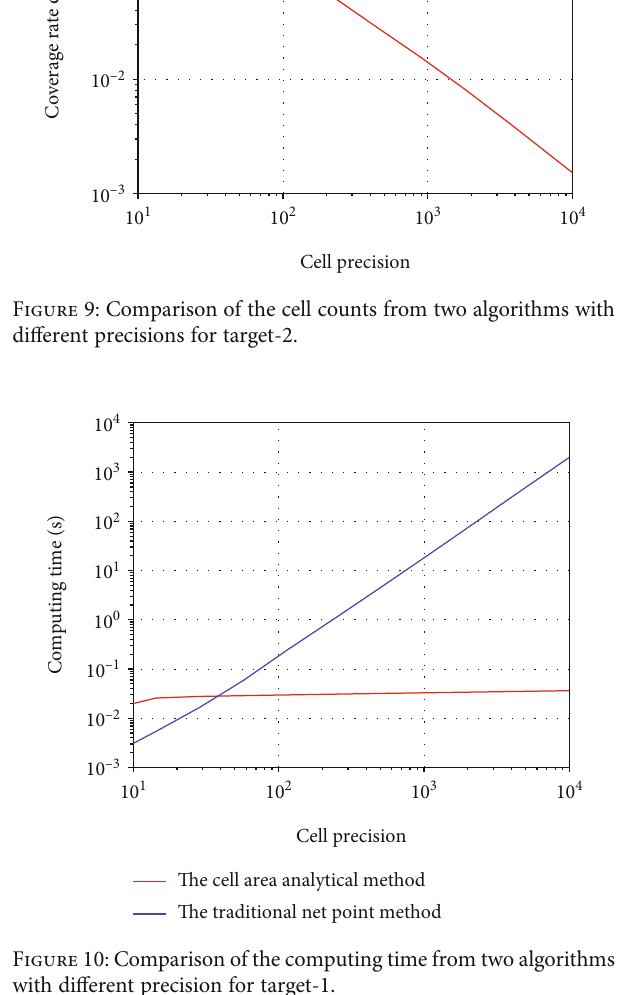
Figure 8: Results of coverage rate with an increase of the cell precision for target-2.